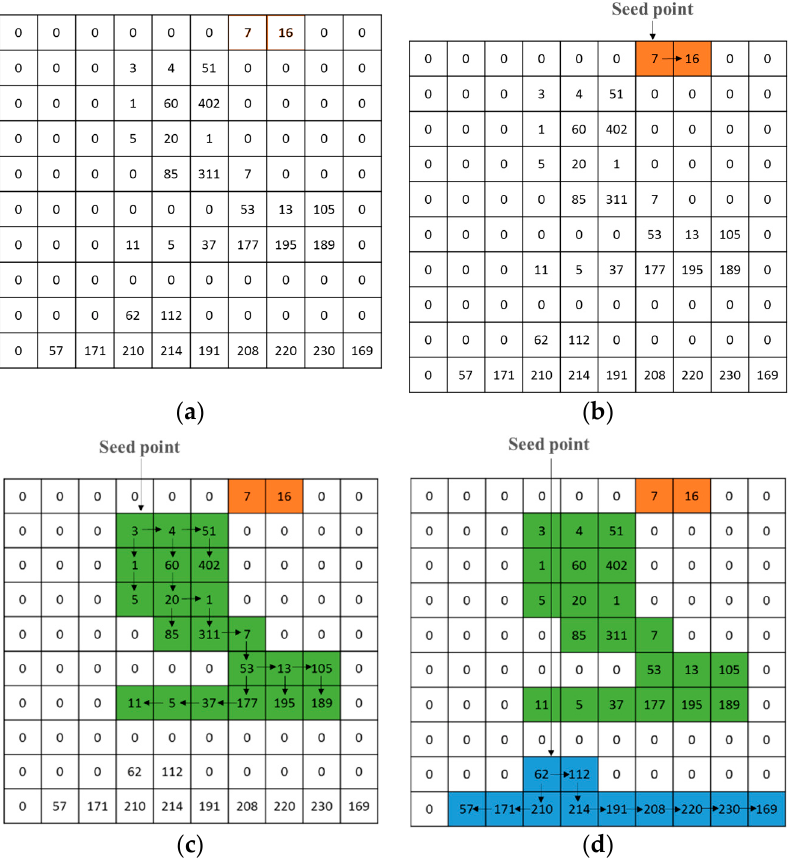
Figure 8. The process of the two-dimensional region growing algorithm. From ( a ) to ( d ), these figures represent how cells in a table cluster into three different parts, and arrows in these figures represent the order that the algorithm finds valid cells.